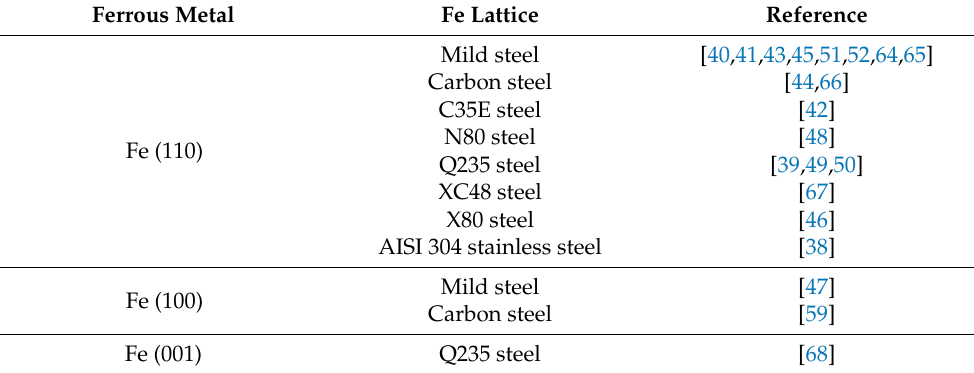
Table 2. Fe surfaces used to resemble several types and grades of ferrous metals in MD